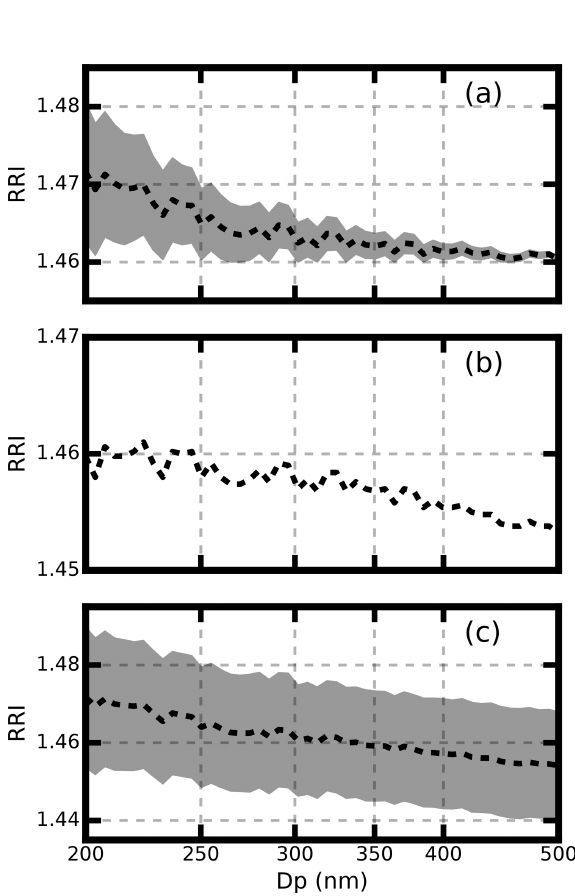
Figure 7. The retrieved aerosol RRI at different aerosol diameters. The shaded portion represents the 5th and 95th percentiles.